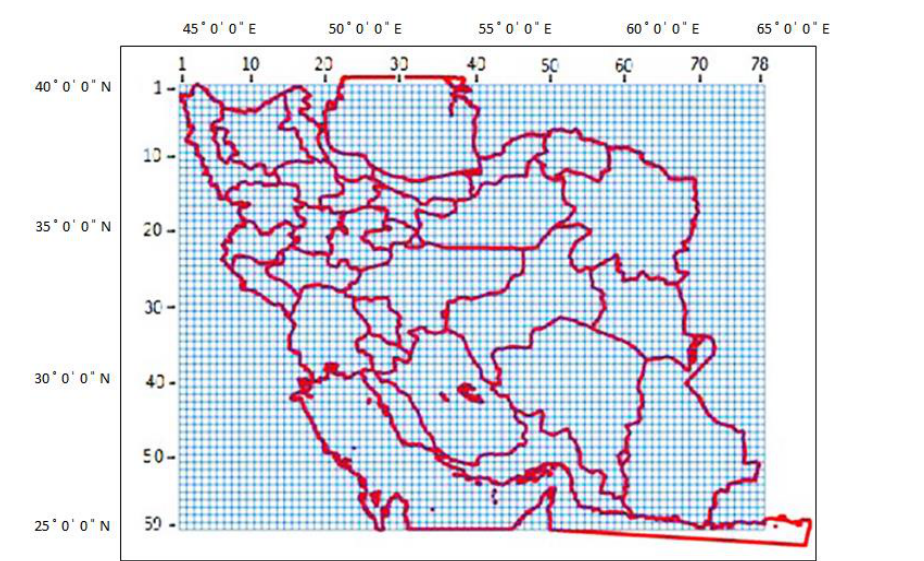
Figure 2. Satellite pixels network over the whole country of